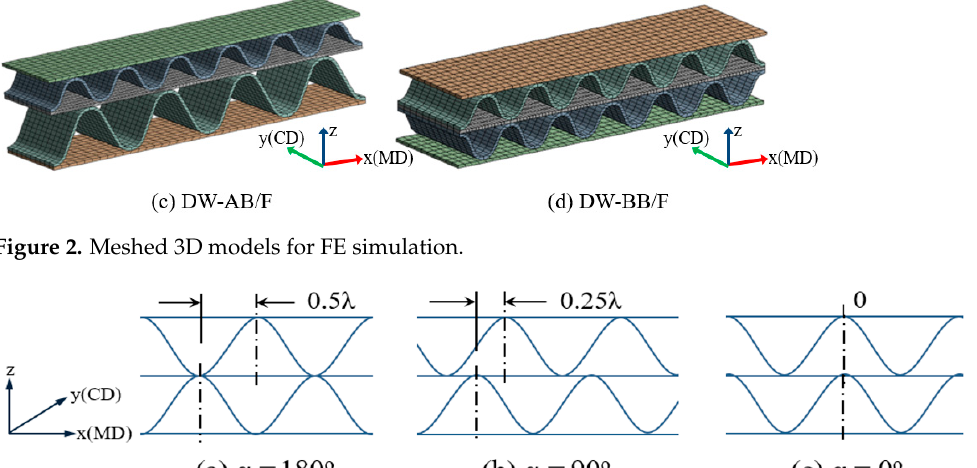
Figure 3. DW-BB/F of different phase angle ( α ) applied to the FEA. ( a ) the difference between the phase angle of the upper and lower flute is 180 ° , ( b ) the difference between the phase angle of the upper and lower flute is 90 ° and ( c ) the difference between the phase angle of the upper and lower flute is 0 ° .